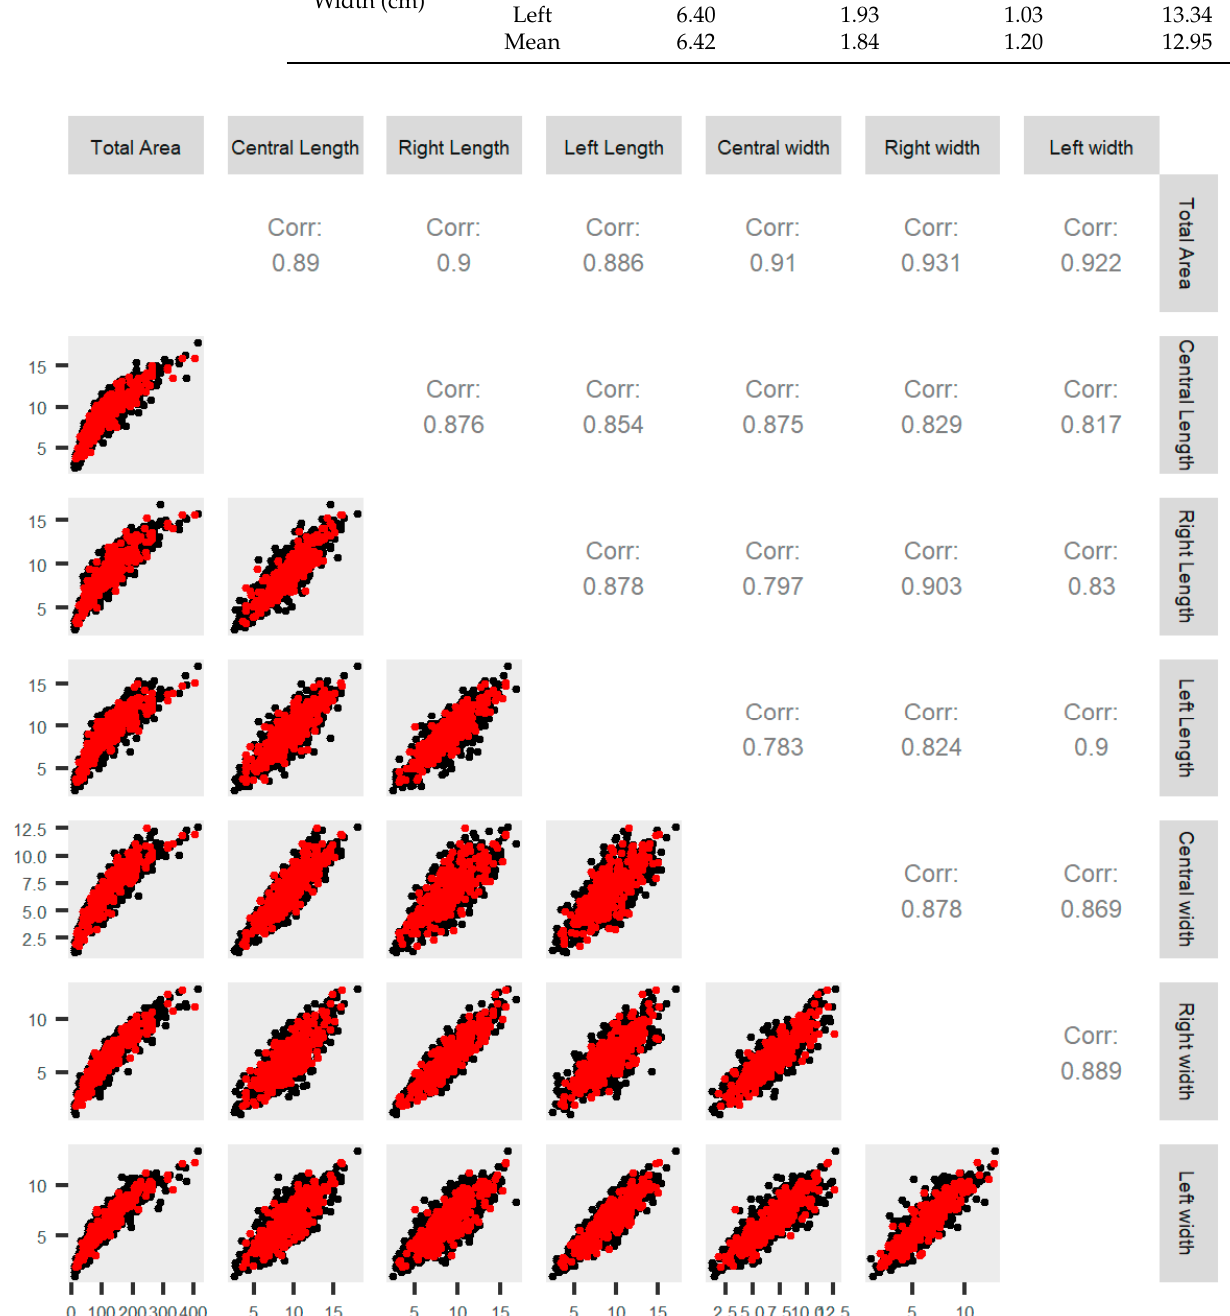
Figure 1. Scatter plots matrix between leaf total area versus length and width of the central, right, and left leaflet of leaves in common bean. Validation observations in red, training observations in black. Corr: Pearson correlation coefficients.